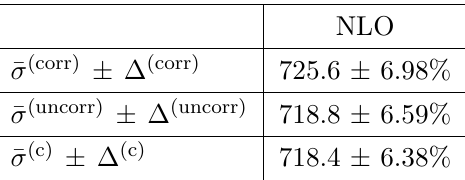
Table 5 . Same as table 3 for the NLO total cross sections for the top pair production cross section √ NLO for s = 13 TeV. In this case, the NNLO central value is 786 . 0 pb.